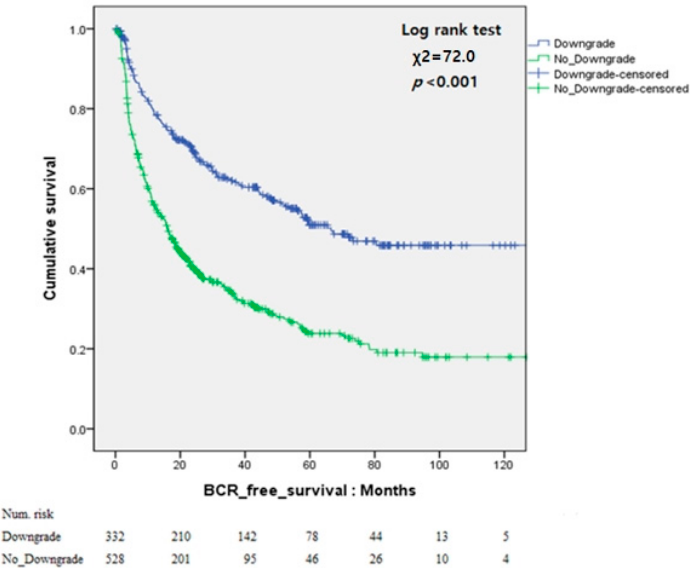
Figure 1. Kaplan–Meier curves for biochemical recurrence (BCR)-free survival according to pathologic Gleason score downgrade.